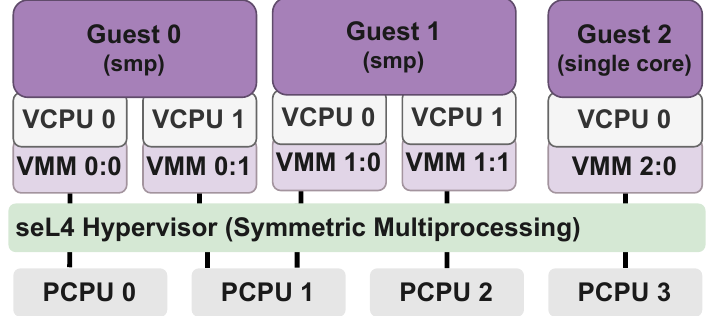
Figure 4. Hybrid Multiprocessing Configuration